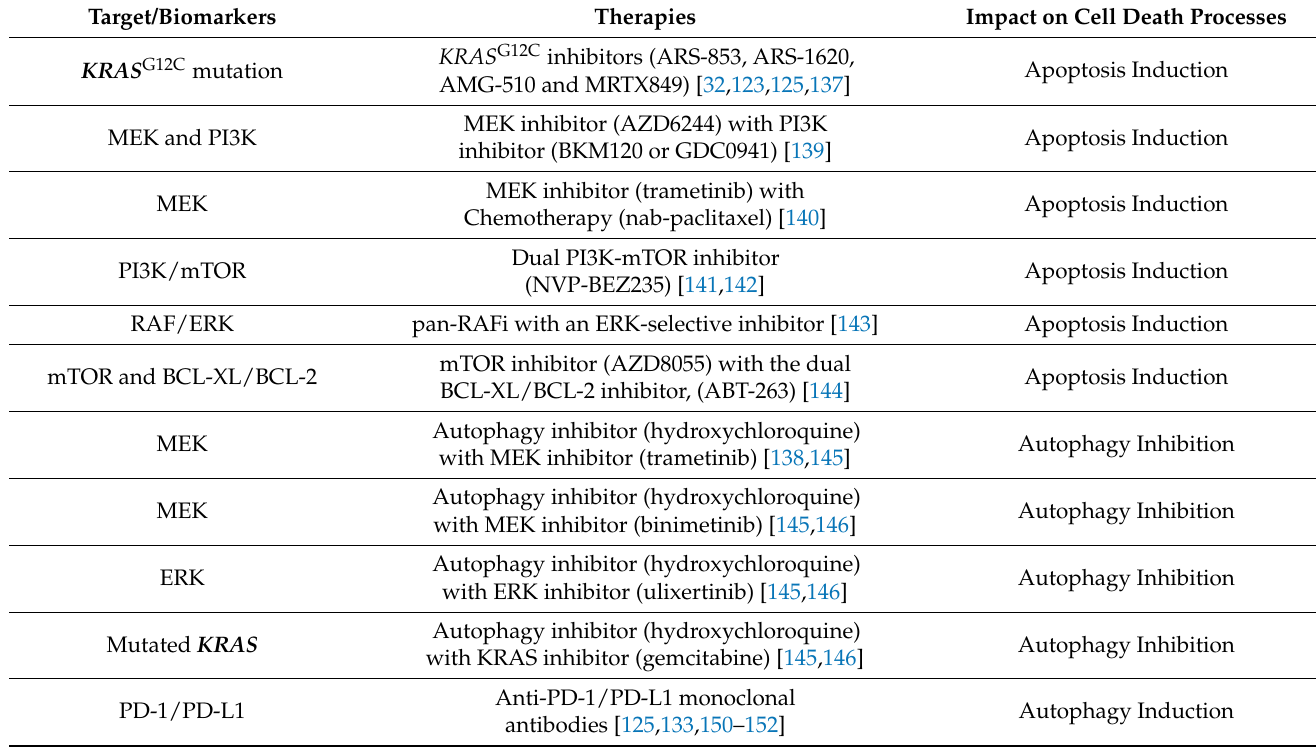
Table 1. New therapeutic approaches targeting KRAS-Induced Cell Death Resistance.